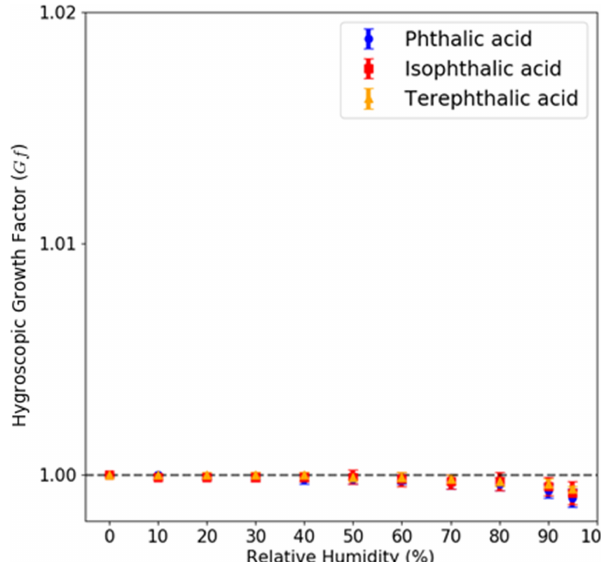
Figure 8. Subsaturated measurements for pure AAA samples ob- tained using the VSA setup are shown. The mass hygroscopic growth factor is shown with respect to the relative humidity (RH). The measurements show that neither of PTA, IPTA or TPTA show any mass-based growth as the RH is increased from 5% to